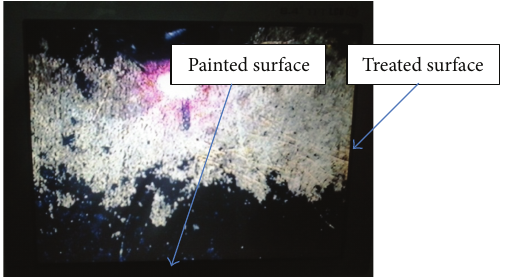
Figure 3: Optical image showing the treated